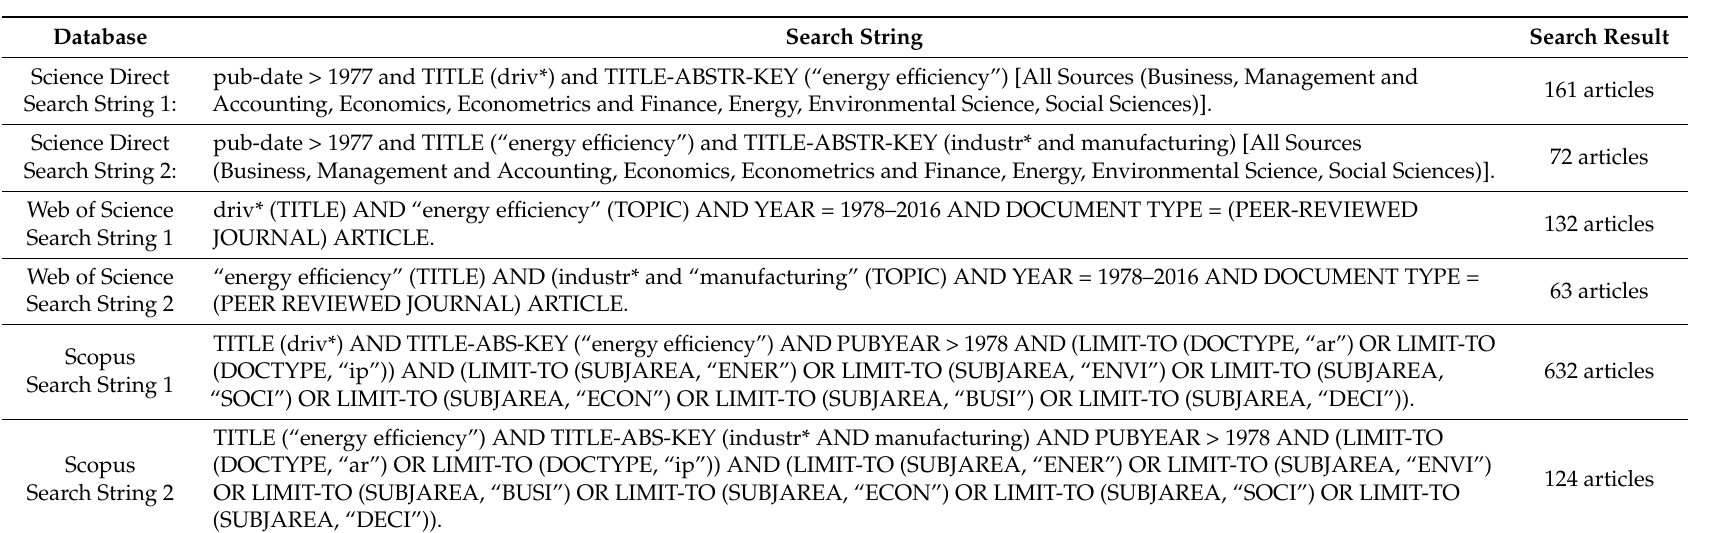
Table A1. Search strings applied in the databases (the search was conducted on 25 January